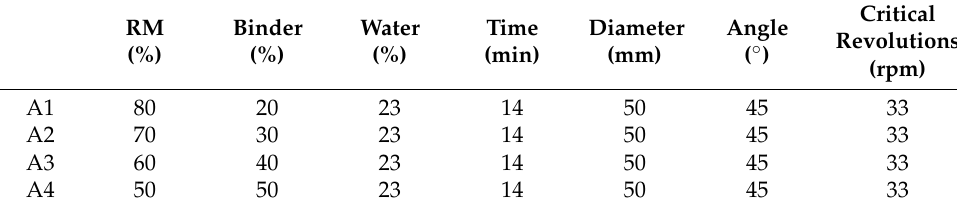
Figure 2. XRD pattern of binder materials.